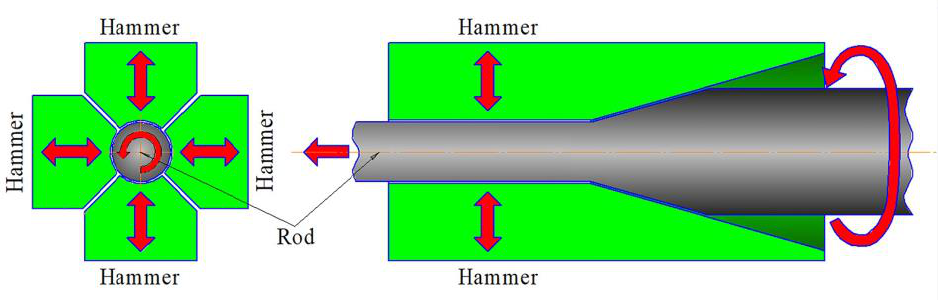
Figure 1. Scheme of cold rotary swaging. Red arrows indicate the movement direction of the rod and hammers during processing.